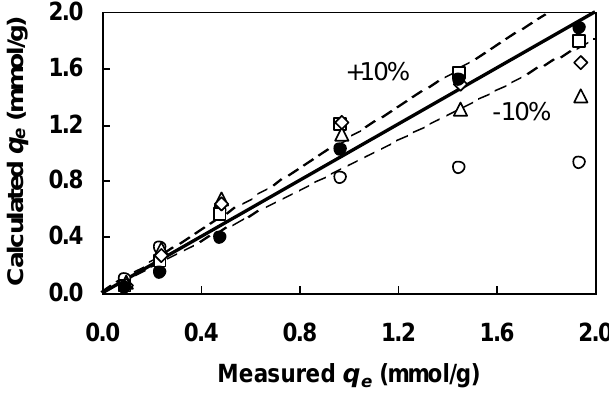
Figure 3. Comparison between the Figure 1 equilibrium data and q Langmuir equation (Equation (3)) containing parameters estimated from the following linearizations: Lineweaver-Burk (open circles), Hanes-Woolf (triangles), Eadie-Hofstee (diamonds), Scatchard (squares), and parameters estimated from the GA (filled